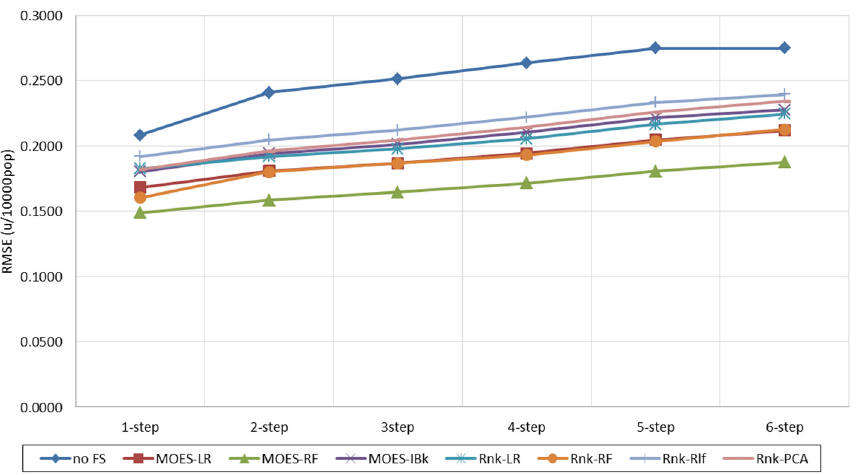
Figure 2. Comparative evolution of GBV complaints’ RMSE evolution obtained via an RF predictive algorithm with different FS techniques.